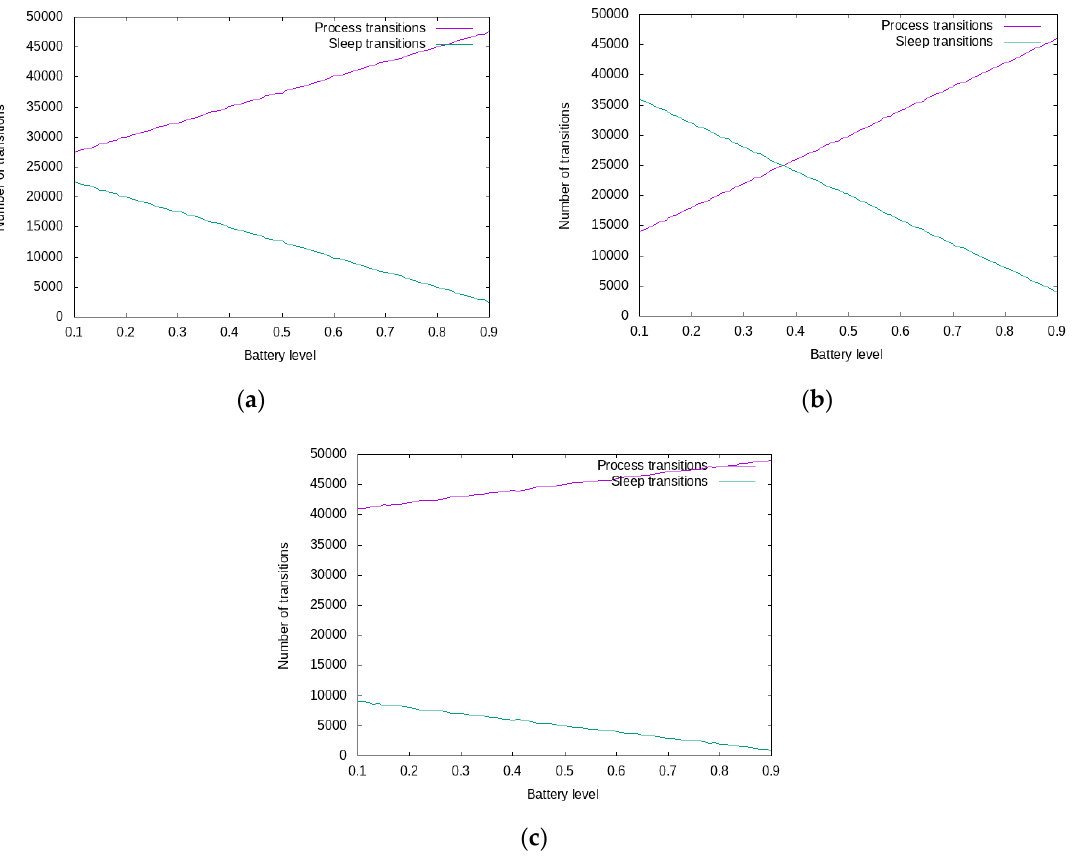
Figure 4. SPN consumption model of the IoT Security Gateway: ( a ) Uniform distributed real time/best effort messages; ( b ) Best effort predominant message; ( c ) Real time predominant messages.